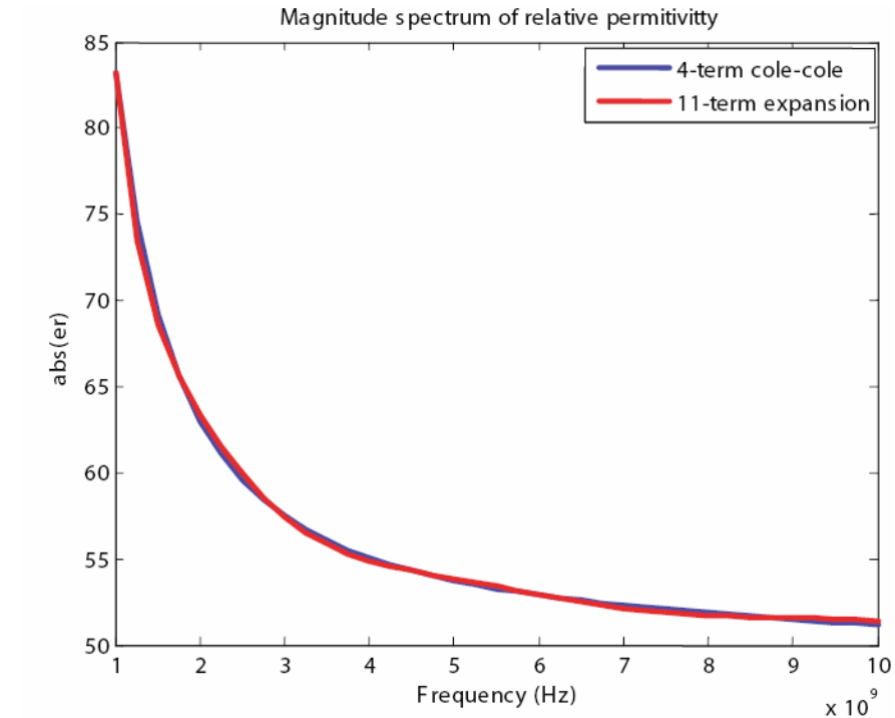
Figure 12. Magnitude spectrum of the relative permittivity for the 4 term Cole-Cole model and the spectrum